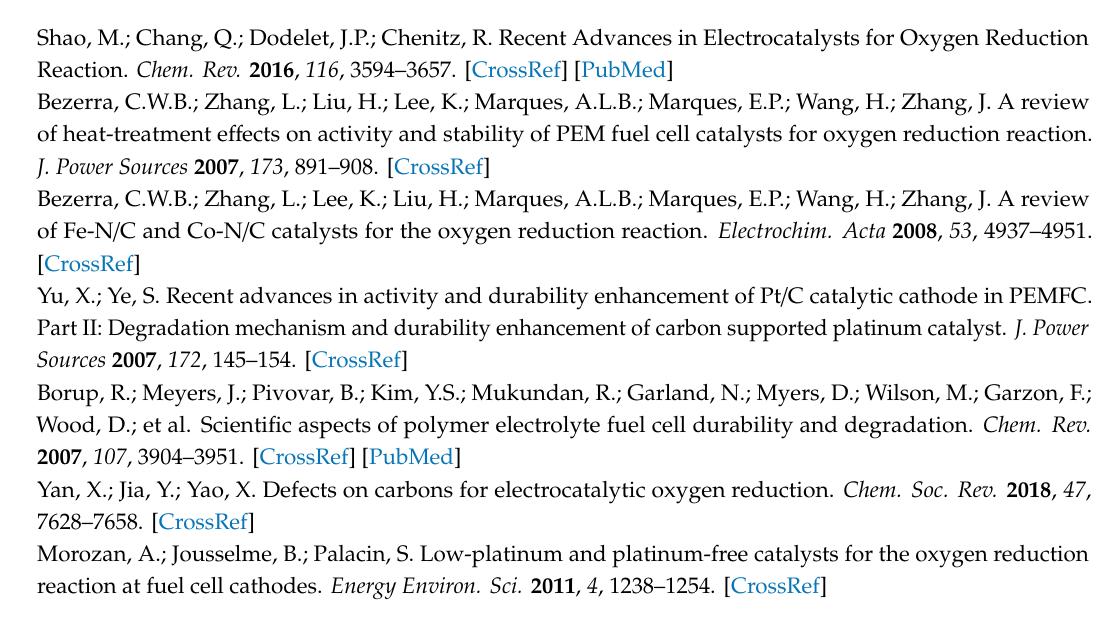
Figure S1: N 2 adsorption 2D-NLDFT-PSD of all KUA-based samples, Figure S2: LSV curves for the catalysts in O2-saturated 0.1 M KOH at 1600 rpm. v = 5 mV /